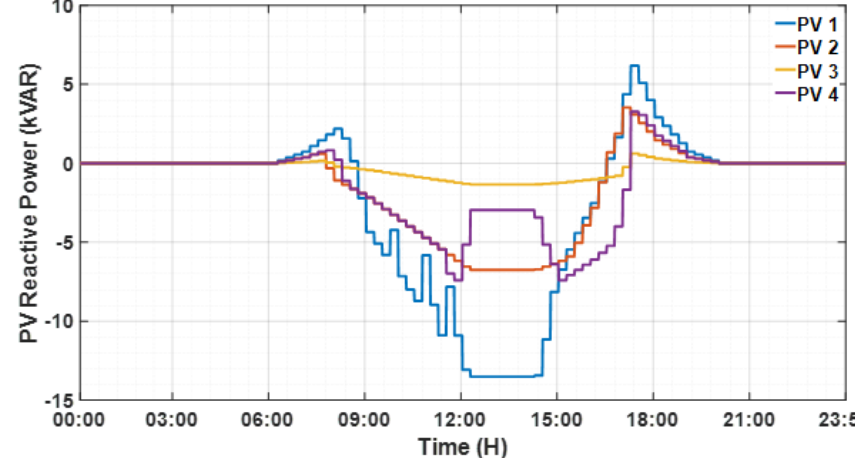
Figure 16. Reactive output of PVs.